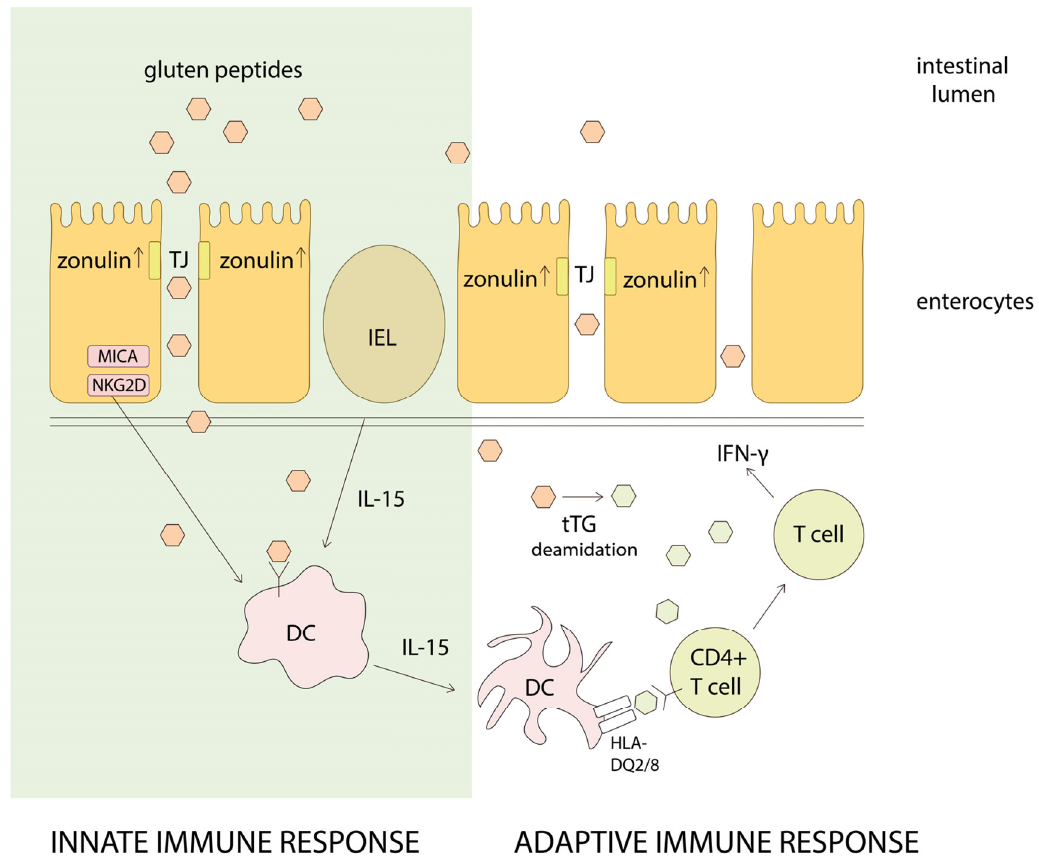
Figure 1. Schematic representation of major pathways in celiac disease (CD) pathogenesis. MICA, NKG2D—stress molecules on enterocytes, IEL—intraepithelial lymphocyte, DC—dendritic cell.